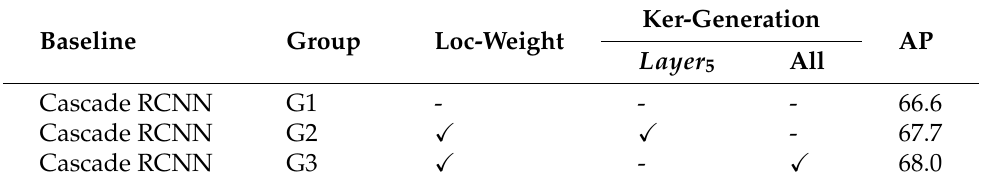
Table 4. Effects of kernel-generation